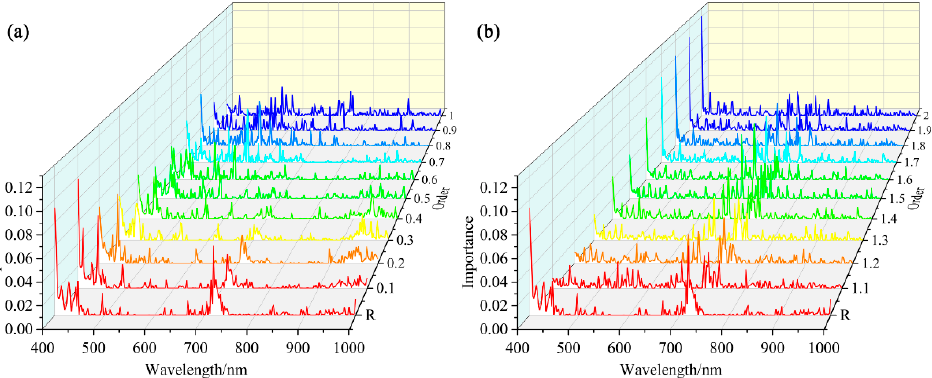
Figure 11. The importance of all bands for 21 derivative orders (0 to 2, with an increment of 0.1 per step). (a) the importance within 0-1 orders, (b) the importance within 1.1-2 orders.